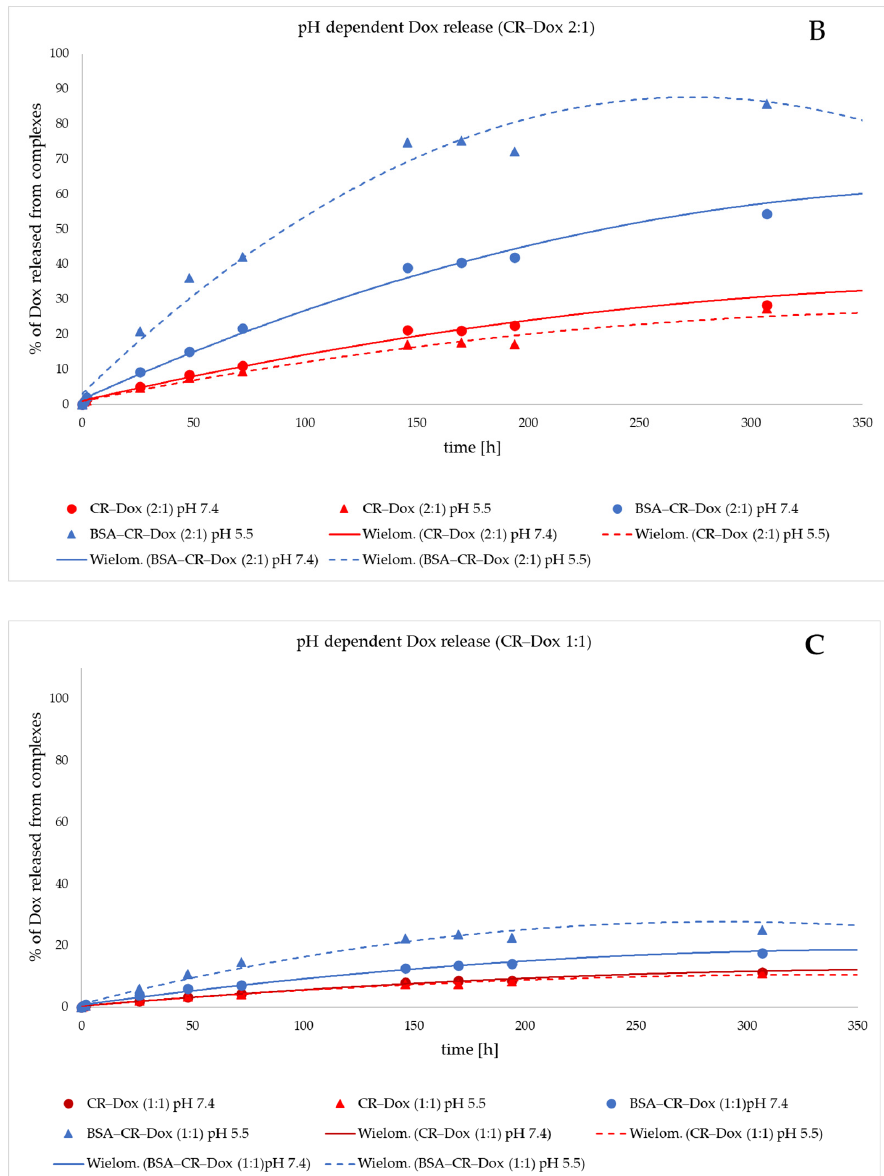
Figure 6. Dialysis analysis. Comparison of Dox release from CR–Dox and BSA–CR–Dox complexes at pH 7.4 and pH 5.5. Dox release rates were compared for three different molar ratios: ( A ) CR–Dox = 5:1 with or without BSA; ( B ) CR–Dox = 2:1 with or without BSA; ( C ) CR–Dox = 1:1 with or without BSA. The results were obtained in three